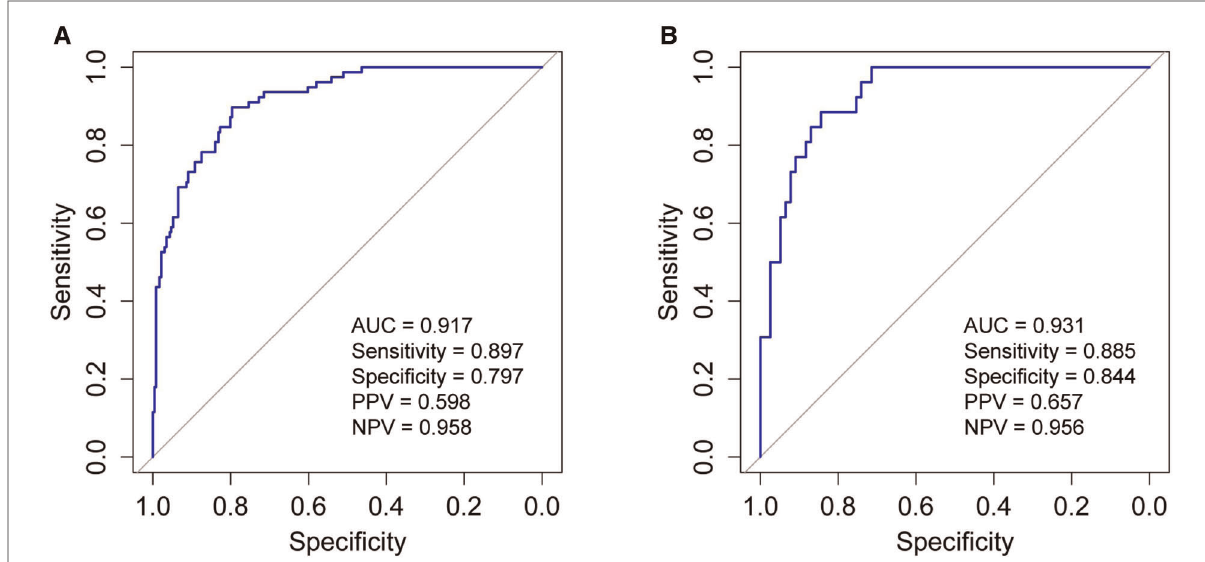
FIGURE 4 Receiver operating characteristic curve (ROC) validation of the moderate and severe BPD risk nomogram prediction. The y -axis represents the true positive rate of the risk prediction, the x -axis represents the false positive rate of the risk prediction. ( A ) The performance in the training set; ( B ) the performance in the validation set. BPD, bronchopulmonary dysplasia; AUC, area under the ROC curve; PPV, positive predictive value; NPV, negative predictive value.